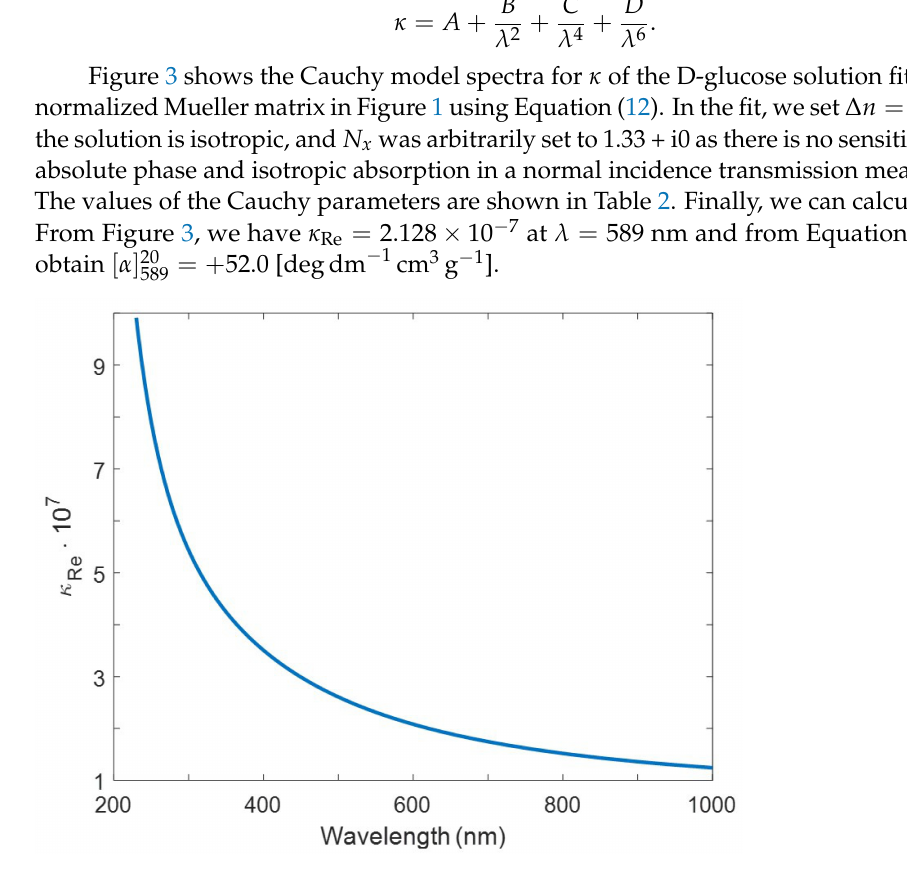
and L (cid:48) . B D